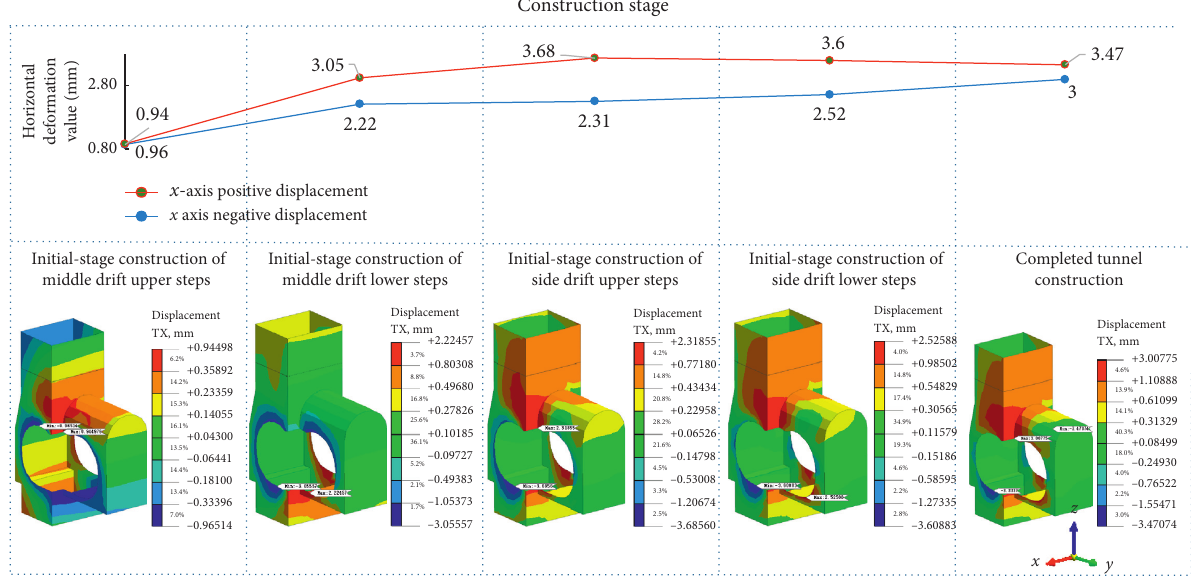
Figure 13: Horizontal deformation cloud of supporting structure.